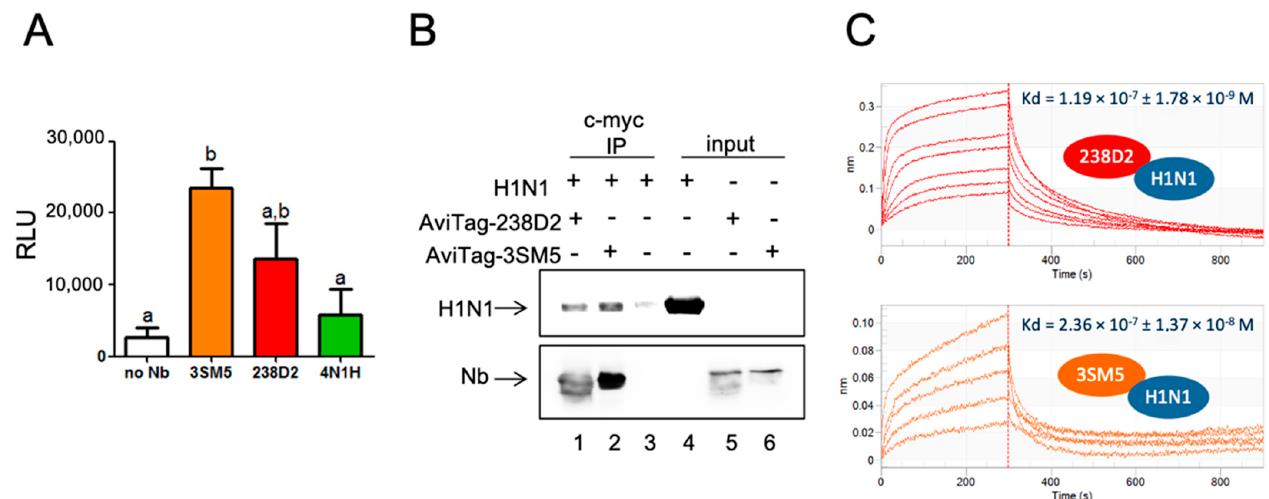
Figure 4. 238D2 binds A/SOLOMON ISLANDS/3/2006 hemagglutin. ( A ) ELISA on H1N1. H1N1 was coated on MaxiSorp plates and incubated with the myc-tagged Nb at 1 µM. Nb was revealed with an HRP-coupled anti-c-myc antibody. Here are shown luminescence signals in mean +/ − sem obtained from 5 independent experiments. Identical letters show no statistical difference, and different letters show statistical differences at p < 0.05. ( B ) Nb-directed immuno-precipitation of H1N1. Magnetic beads were coupled to an anti-c-myc antibody and exposed to a mixture of H1N1 and the biotinylated c-myc-tagged 238D2 (AviTag-238D2, lane 1), or the biotinylated c-myc-tagged 3SM5 (AviTag-3SM5, lane 2) or to H1N1 alone (lane 3). In lanes 4, 5, and 6 are shown the inputs. The beads eluate, and the input samples were analyzed by Western blot. H1N1 was revealed by an anti-His tag primary antibody (upper panel), and the Nb by an AlexaFluor680-coupled streptavidin (lower panel). ( C ) BLI streptavidin sensors were loaded with biotinylated AviTag-238D2 (top) or AviTag-3SM5 (bottom). Association of H1N1 on the 238D2 or 3SM5 was measured at 84.75 (bottom curve), 127.1, 169.5, 254.2, 339, 508.5 and 847.5 nM (upper curve). The dissociation occurred in the running buffer. The K D indicated on the graph was obtained from the simultaneous fit of the 5